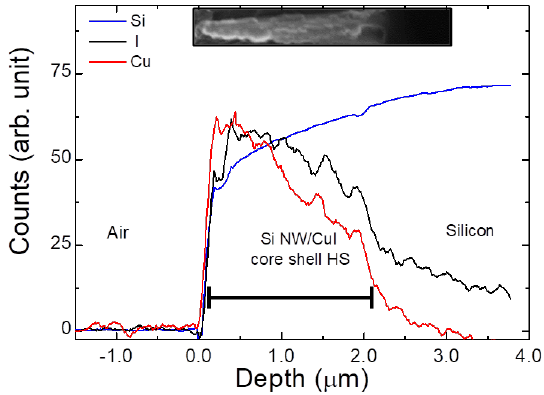
Figure 3. EDX analysis on the cross-section profile of the core-shell Si NWs/CuI heterostructure reporting the Si-K α , Cu-L α and I-L α X-ray emissions displayed in blue, red and black lines, respectively.